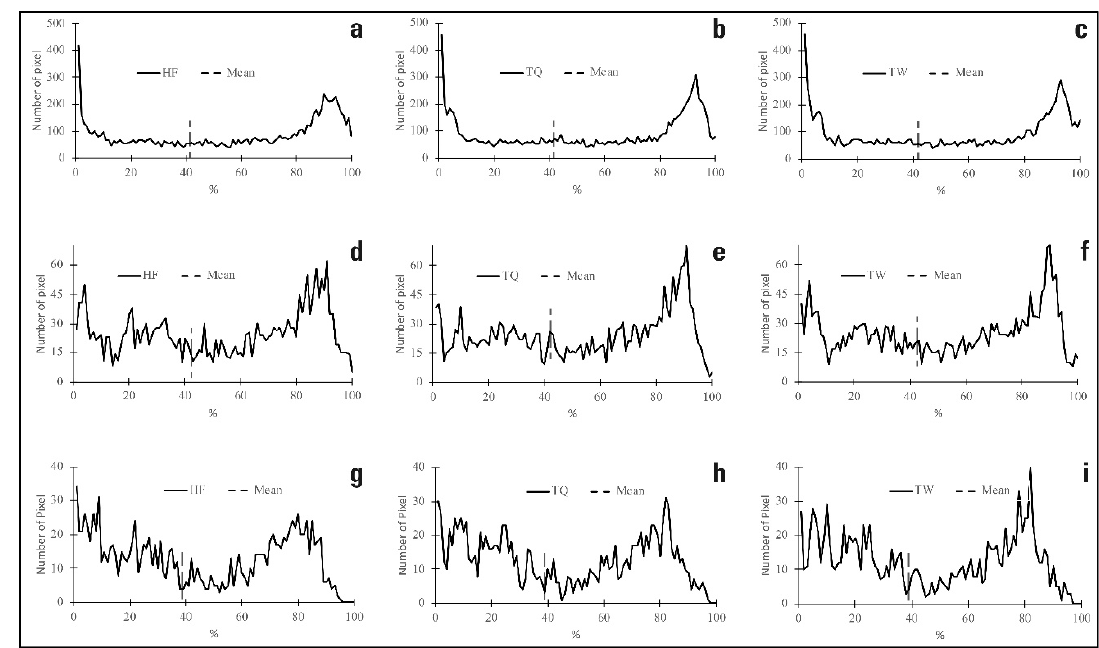
Figure 6. Histograms of derived ISA from a subset area highlighted in Figure 3. The X-axis is the percentage of ISA and the Y-axis is the total numbers of ISAs derived from images with half (HF), three-quarters (TQ), and twice (TW) the Landsat OLI SNRs at 10-m ( a – c ), 20-m ( d – f ), and 30-m ( g – i ) resolutions. The central vertical dashed lines in each panel represent the mean of the ISAs in each estimate.